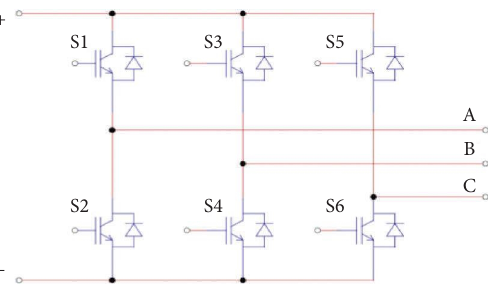
Figure 5: 2-level three-phase VSI